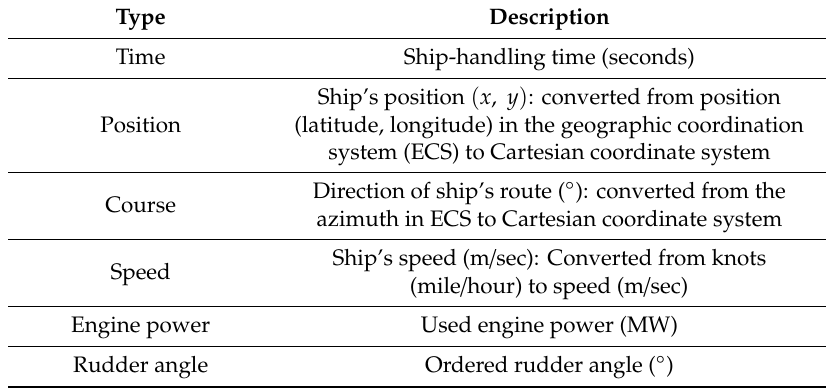
Table 5. Types of experimental data obtained from the logged histories in the